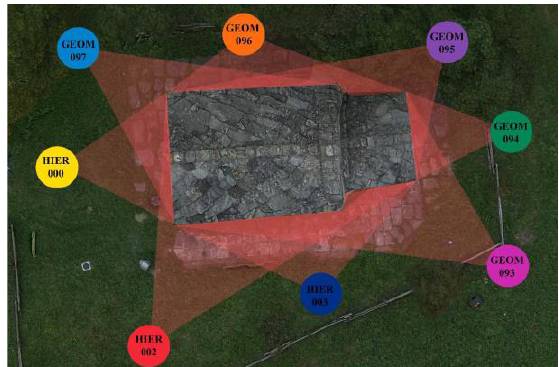
Figure 7. Position of the 8 external scans The final model was georeferenced by means of the coordinates of the measured markers, both on the internal and external